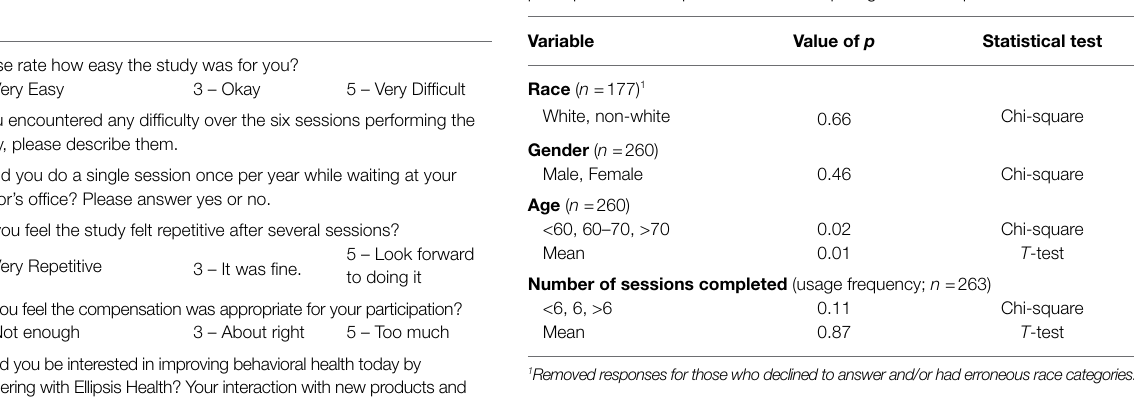
TABLE 2 | Demographic characteristics of Desert Oasis Healthcare study participants for Group Positive and Group Negative Chi-square and t